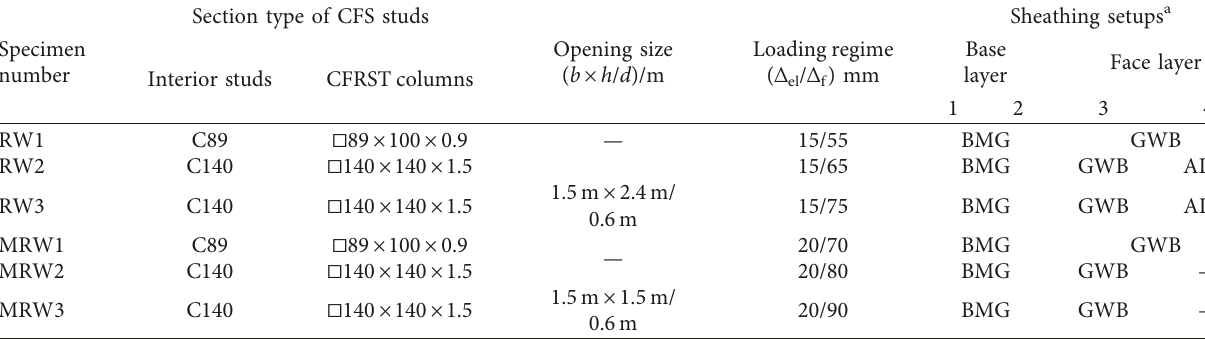
Table 2: Details of test specimens [18, 23].